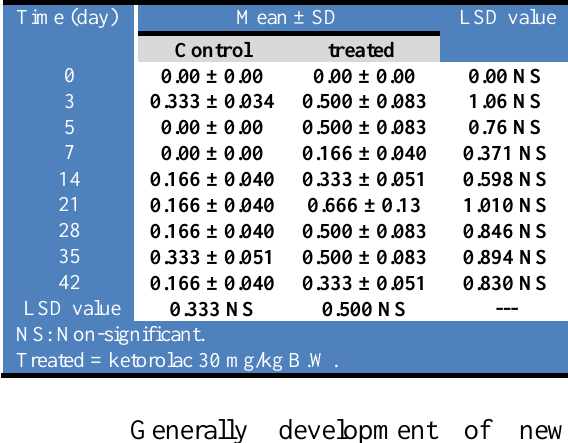
Table, 12: Shows Eosinophils (%) in control and ketorolac treated